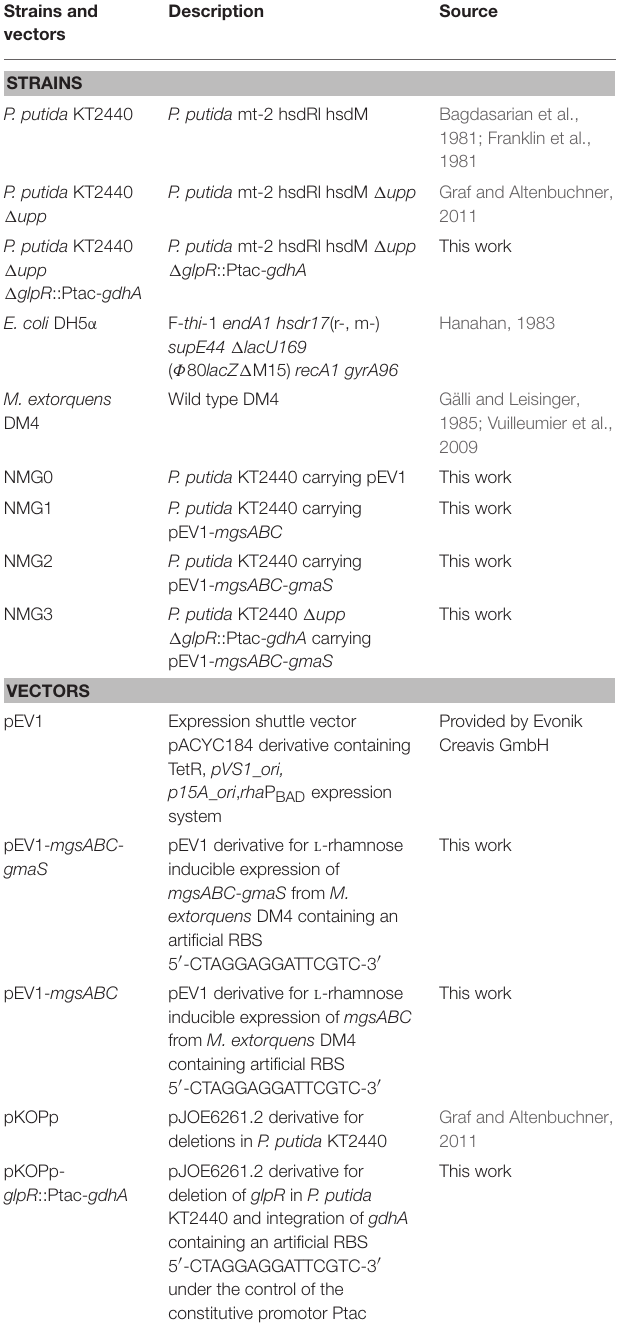
TABLE 1 | Strains and vectors used in this